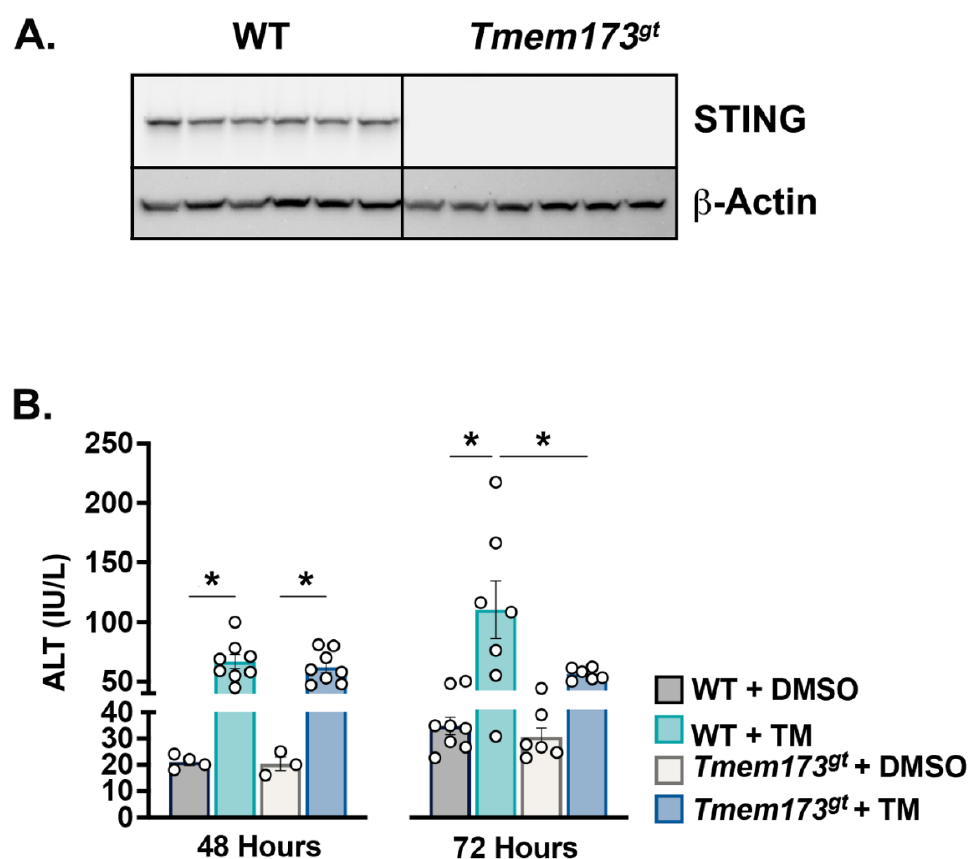
Figure 1. Tunicamycin-induced liver injury is limited 3 days post-injection in the absence of STING. ( A ) Western blot of whole liver samples from WT and Tmem173 gt mice probed with a STING antibody. ( B ) ALT levels either 48 h or 72 h post-TM injection in both WT and Tmem173 gt mice. Graphs represent means ± SEM. * p < 0.05 between highlighted groups.